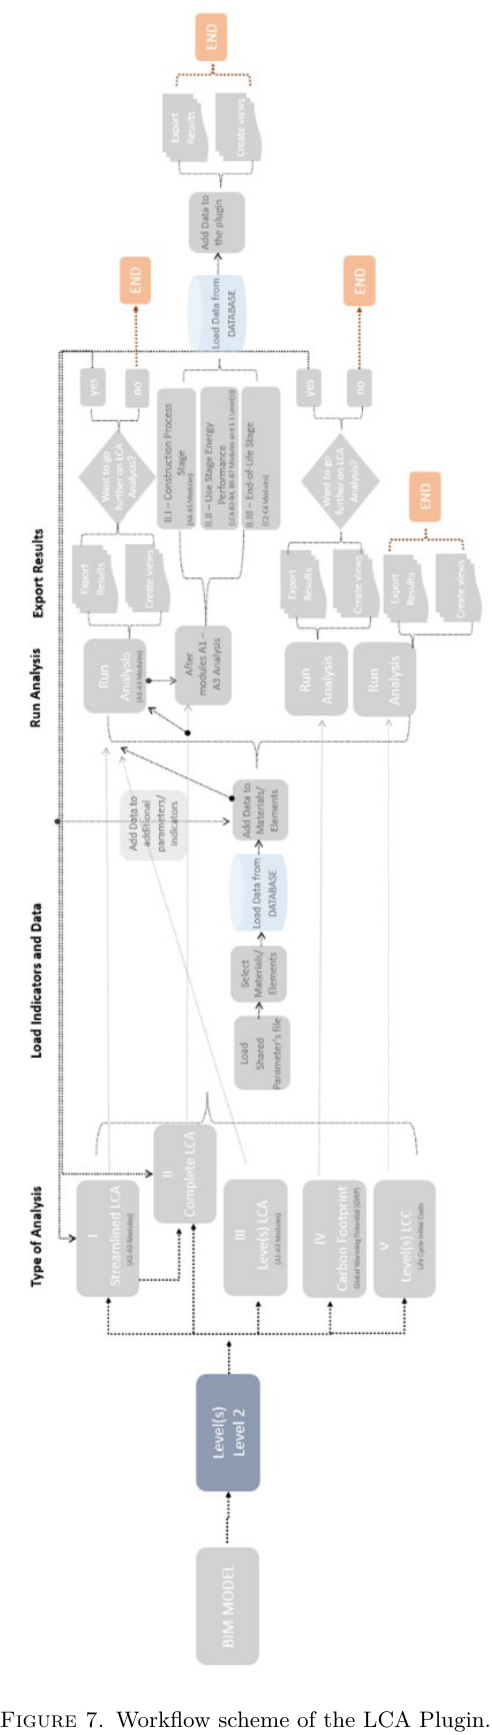
Figure 7. Workflow scheme of the LCA